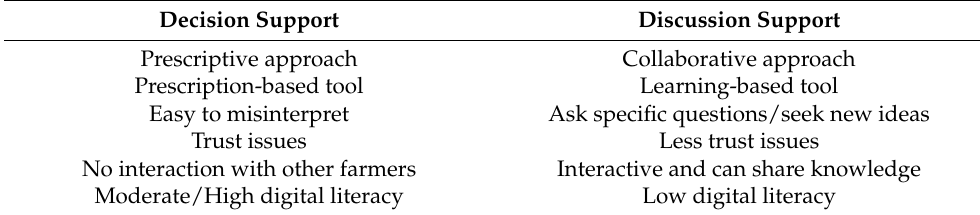
Table 10. Difference between decision support and discussion